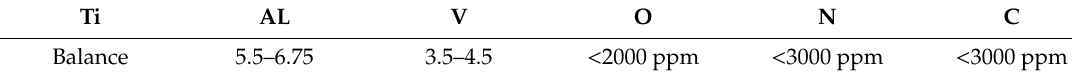
Table 1. Chemical composition of Ti6Al4V.